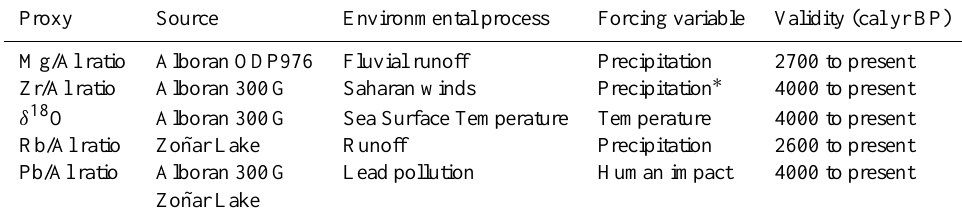
Table 1. Geochemical proxies applied for this study from the Alboran Sea and Zo˜nar Lake sediments.